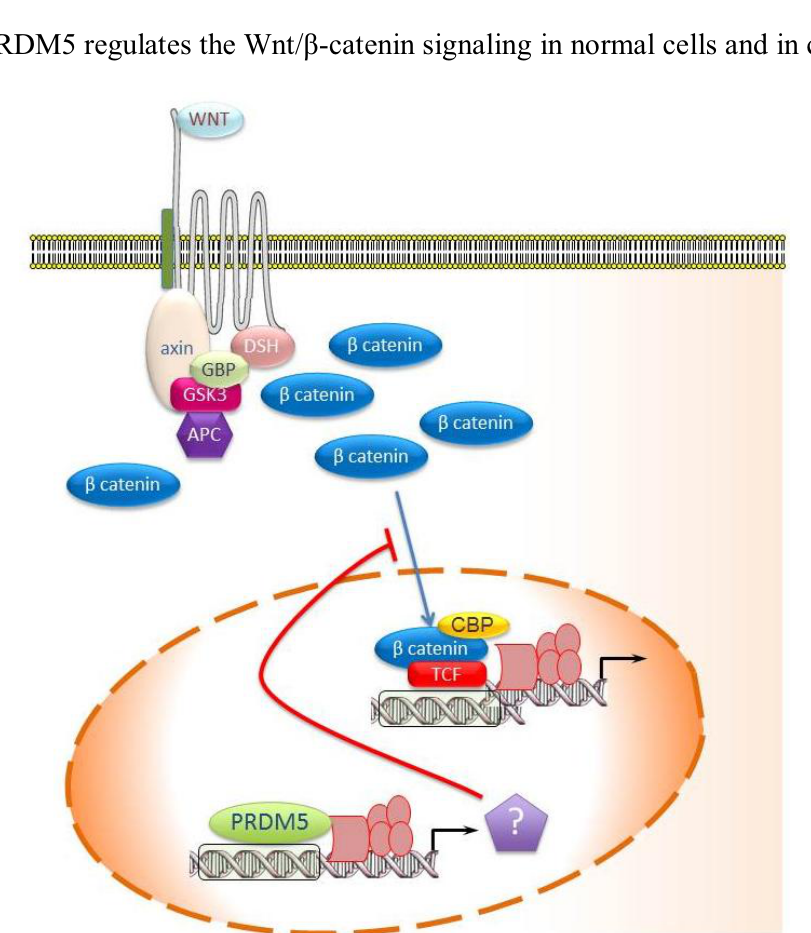
(cid:55)(cid:75)(cid:72)(cid:3)(cid:58)(cid:81)(cid:87)(cid:18)(cid:533) -catenin pathway is activated when a Wnt ligand binds to a seven-pass transmembrane Frizzled (Fz) receptor. The recruitment of the scaffolding protein Dishevelled (Dvl) inactivates the APC (adenomatous polyposis coli) protein (cid:85)(cid:72)(cid:86)(cid:88)(cid:79)(cid:87)(cid:76)(cid:81)(cid:74)(cid:3)(cid:76)(cid:81)(cid:3)(cid:533) -catenin stabilization, which accumulates (cid:68)(cid:81)(cid:71)(cid:3)(cid:87)(cid:85)(cid:68)(cid:89)(cid:72)(cid:79)(cid:86)(cid:3)(cid:87)(cid:82)(cid:3)(cid:87)(cid:75)(cid:72)(cid:3)(cid:81)(cid:88)(cid:70)(cid:79)(cid:72)(cid:88)(cid:86)(cid:3)(cid:87)(cid:82)(cid:3)(cid:73)(cid:82)(cid:85)(cid:80)(cid:3)(cid:70)(cid:82)(cid:80)(cid:83)(cid:79)(cid:72)(cid:91)(cid:72)(cid:86)(cid:3)(cid:90)(cid:76)(cid:87)(cid:75)(cid:3)(cid:55)(cid:38)(cid:41)(cid:18)(cid:47)(cid:40)(cid:41)(cid:17)(cid:3)(cid:533) -catenin activates Wnt target